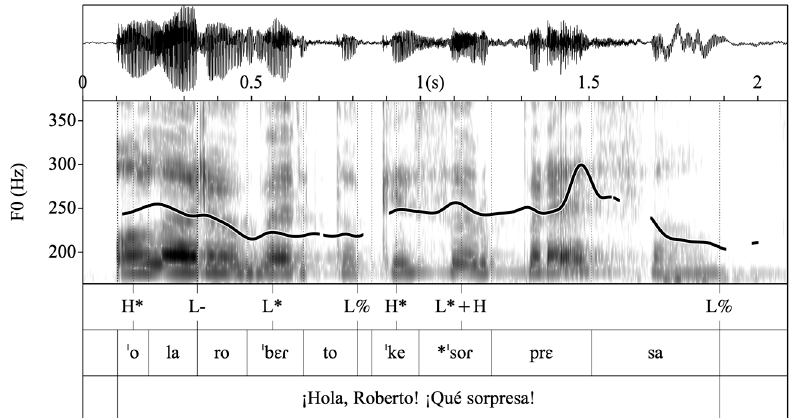
in L2 Italian (F35, level C1) produced with L* L%. L2 Italian (F35, level C1) produced with L* L%.